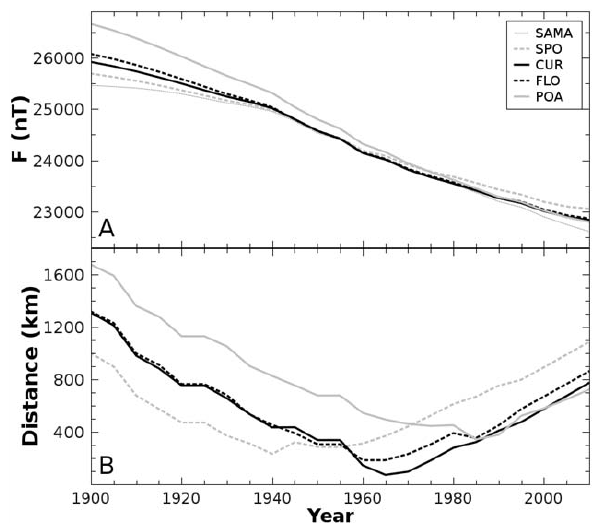
Fig. 2. (A) Time evolution of the geomagnetic field intensity at 5yr resolution for the meteorological station positions and the SAMA center from 1900 to 2010. (B) Distance between each station and the SAMA center between 1900 and 2010.